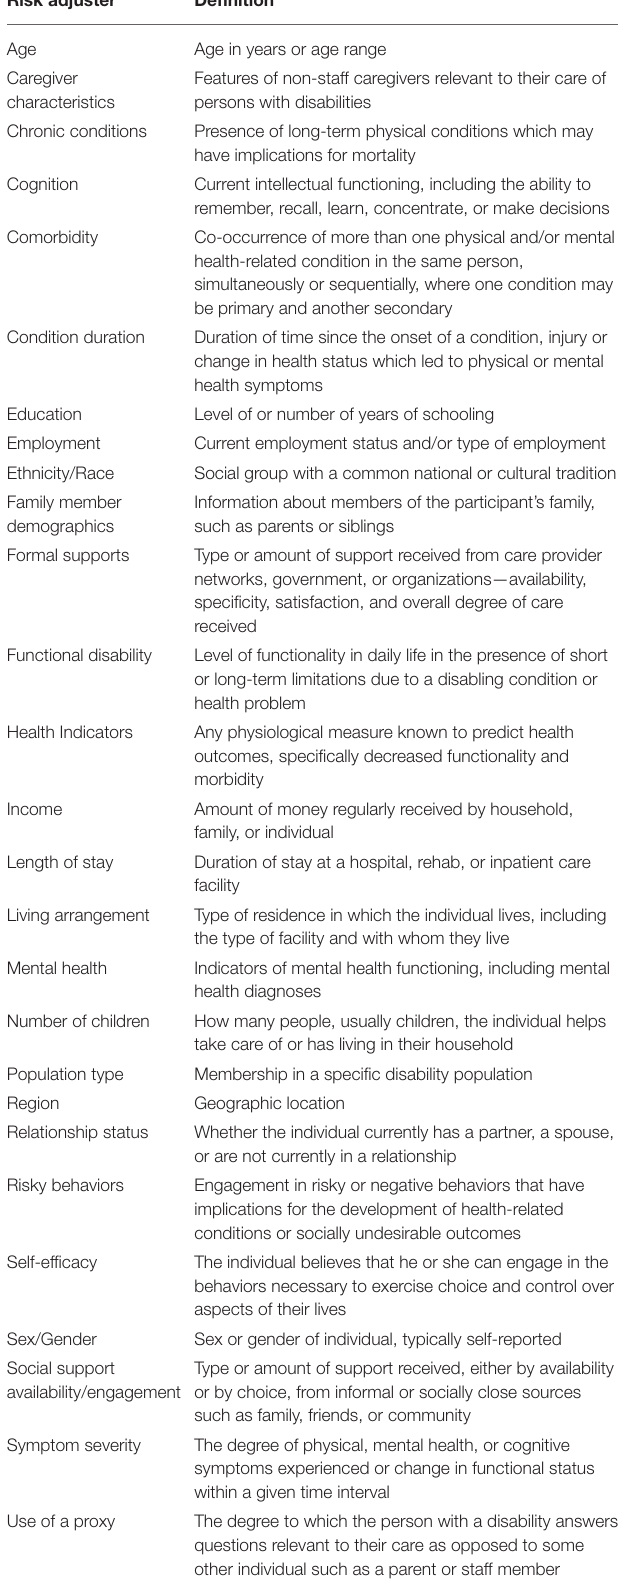
TABLE 2 | Internal definitions used to categorize risk